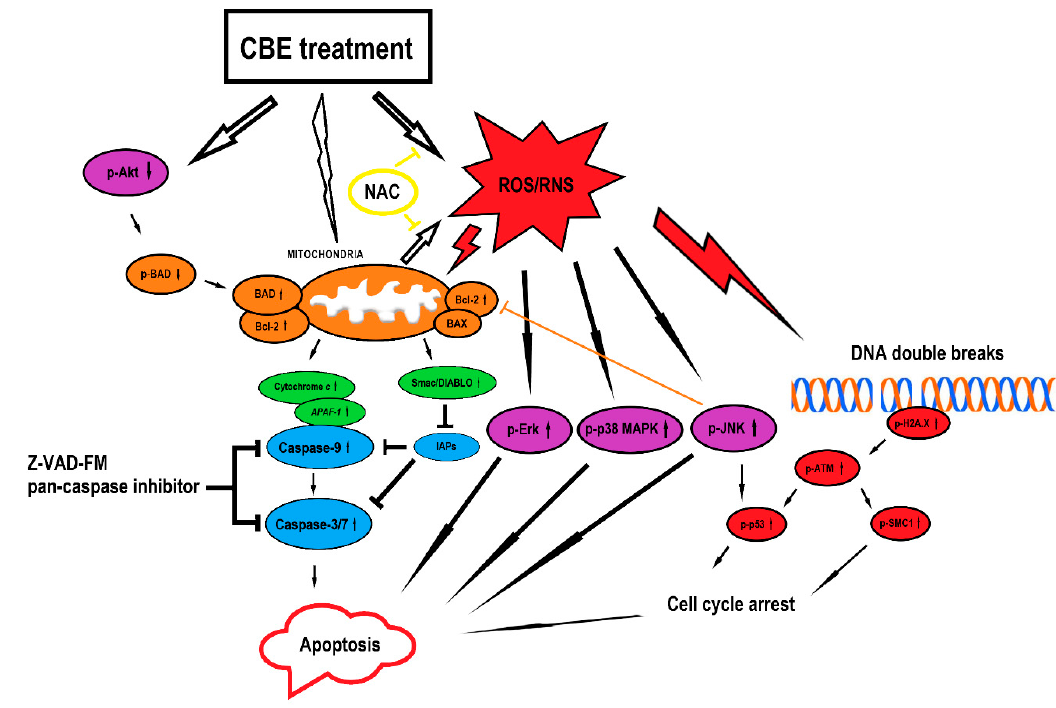
Figure 6. Proposed model of the signaling pathways underlying CBE-induced apoptosis in MCF-7 cells.